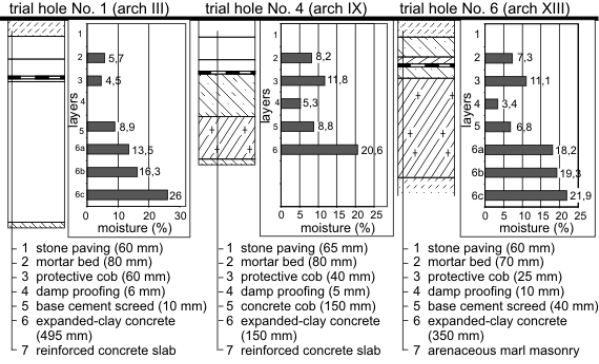
Fig 6. A scheme of bridge body layers and their moisture content as determined by dug test holes